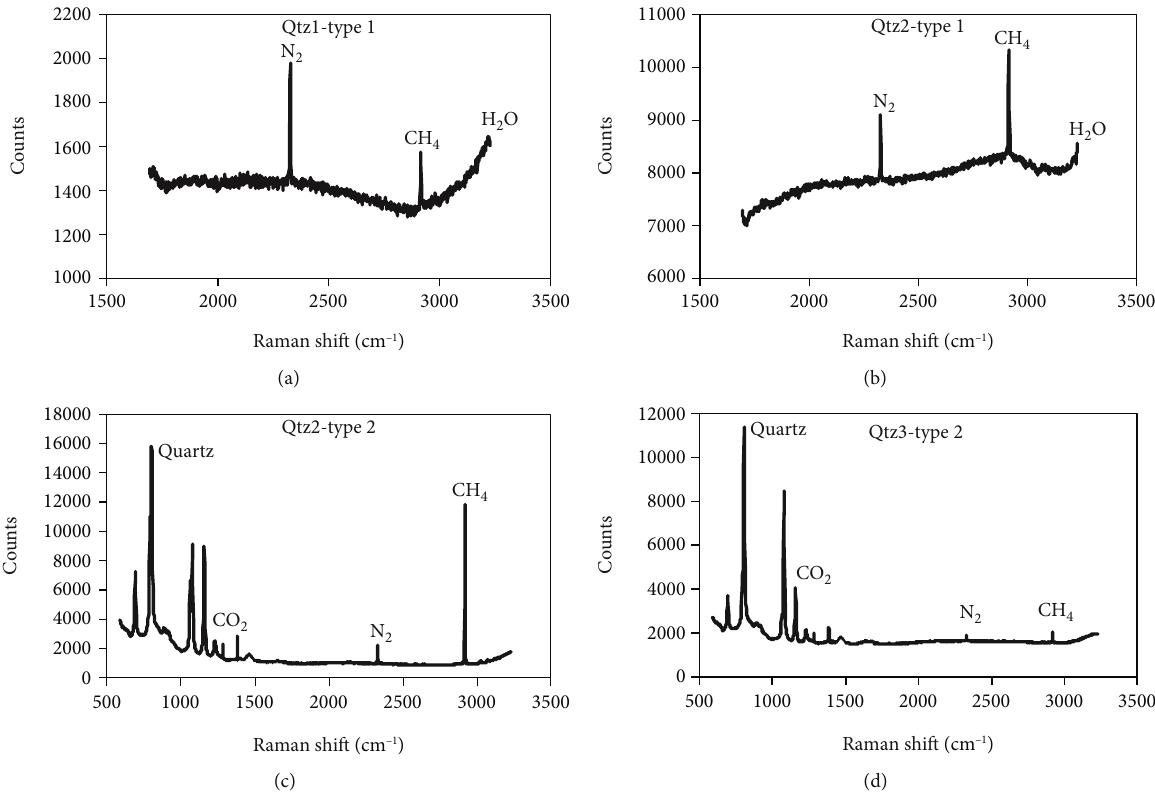
Figure 7: Representative laser Raman spectra of type 1 (a, b) and type 2 (c, d) fl uid inclusions from the Roc Blanc